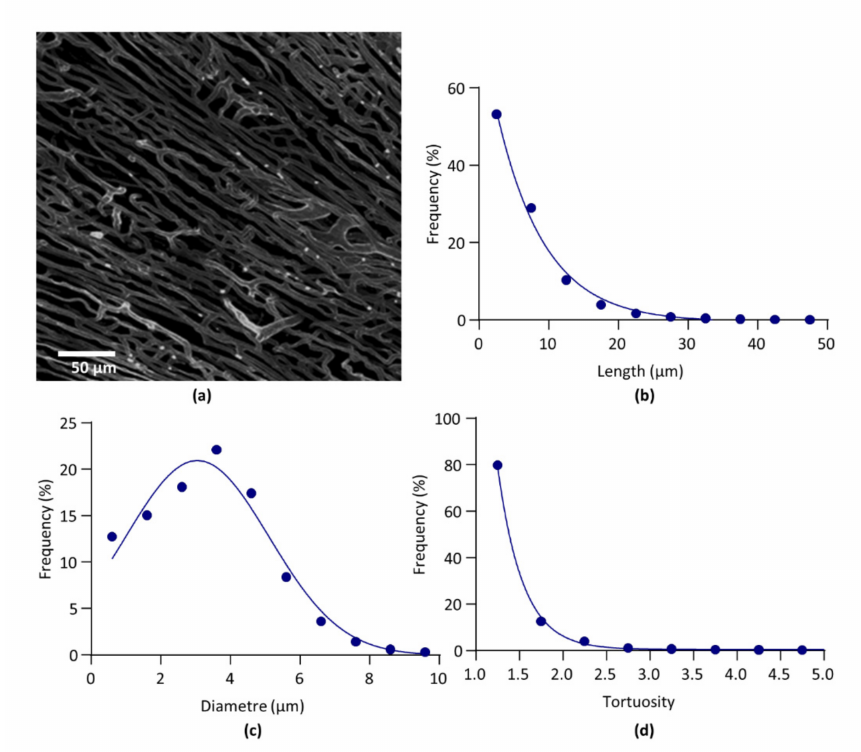
Figure 4. Confocal microscopy. ( a ). Segmented image of left ventricle capillary network. ( b ). Relative frequency distribution of segment length. Data were fitted by one-phase exponential decay. ( c ). Rela- tive frequency distribution of segment diameter. Data were fitted by Gaussian equation. ( d ). Relative frequency distribution of segment tortuosity. Data were fitted by one-phase exponential